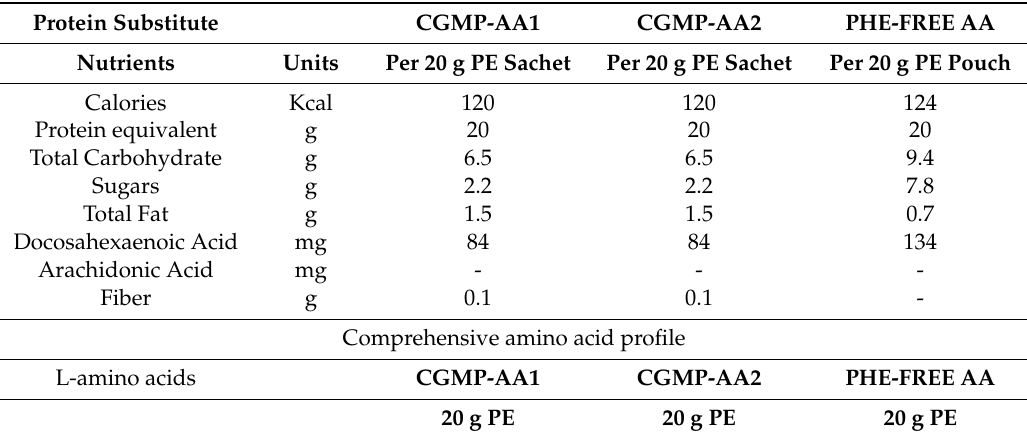
Table 1. Nutritional composition of CGMP-AA 1, CGMP-AA2, and PHE-FREE AA protein substitutes. Protein